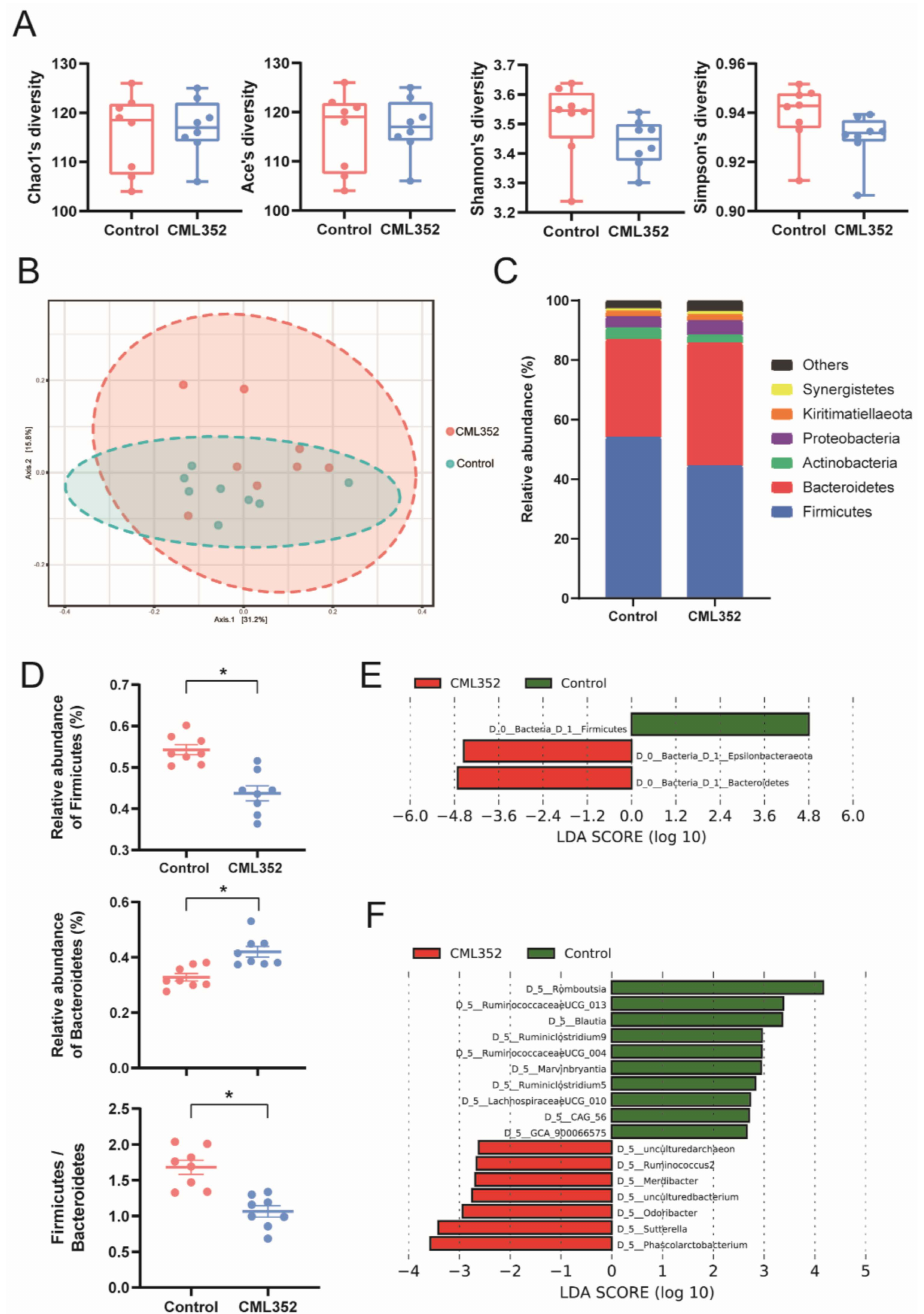
Figure 2. Influence of dietary L. salivarius CML352 supplementation on the gut microbiota composi- tion. ( A ) four different alpha diversity metrics, ( B ) PcoA 2D Graphics generated from MicrobiomeAn- alyst, where red circles represent abundance in hens fed with L. salivarius CML352, blue circles for those of hens in the control group, ( C ) relative abundance of bacterial phyla detected in the samples. Those abundance below 1% were classified into “others”, ( D ) relative abundance of Firmicutes and Bacteroidetes phyla, and the ratio of Firmicutes to Bacteroides, asterisks indicated values significantly different ( p < 0.05) between the groups, ( E ) the LEfSe analysis of the cecum microbiota at the phylum level, and ( F ) the LEfSe analysis of the cecum microbiota at the genus